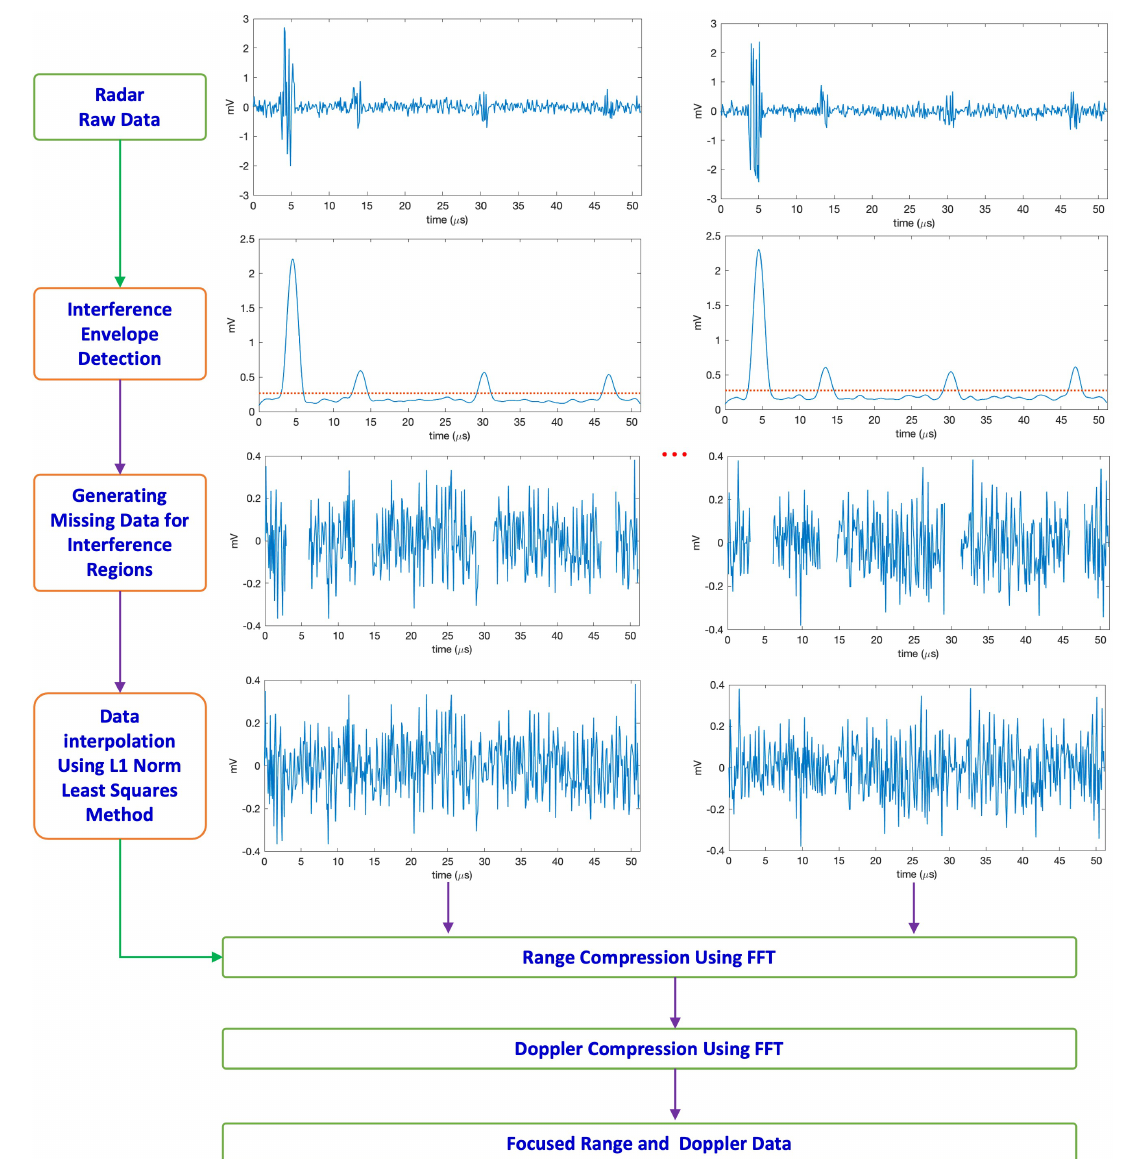
Figure 5. The procedures of the proposed